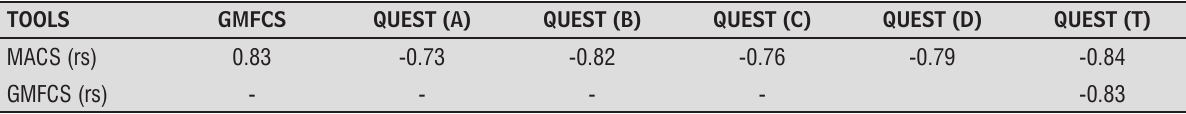
Table 2 - Spearman correlation between the scales used